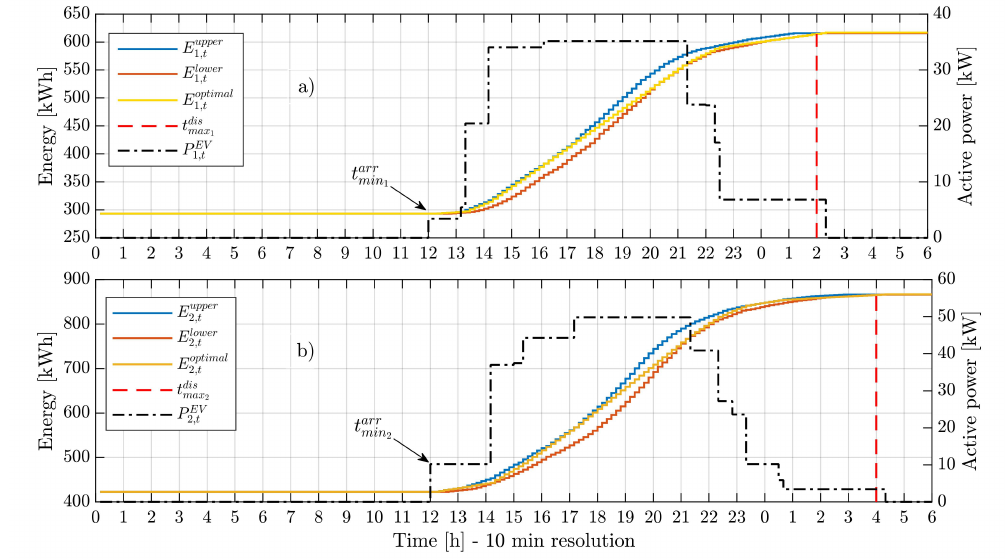
Figure 3. Optimal charging trajectory and charging profile for a moderate penetration level: